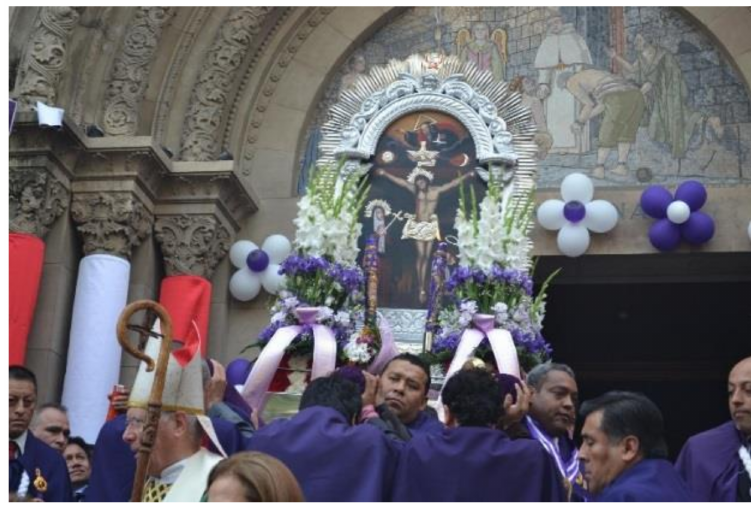
Figure 4. Image of the Lord of Miracles, October